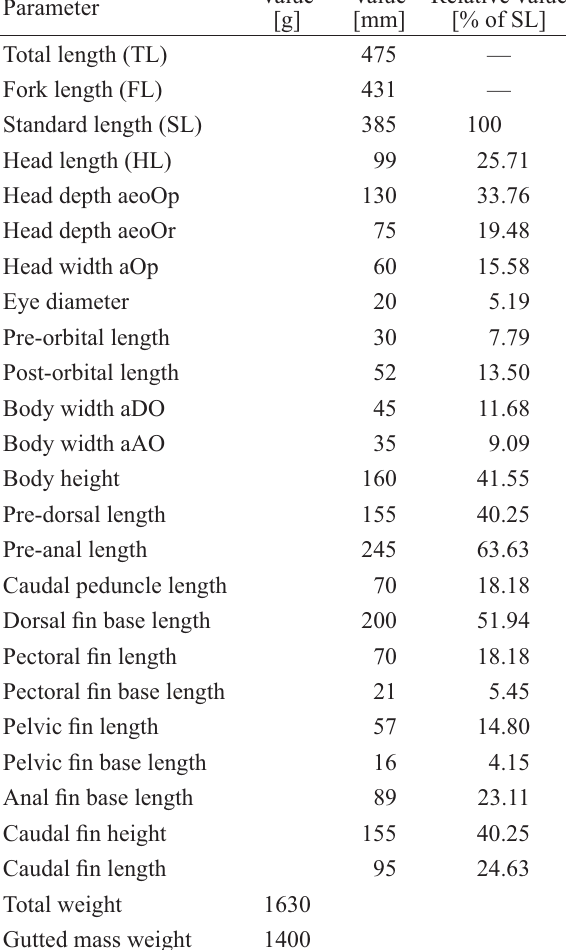
Morphological data for the specimen of Kyphosus saltatrix caught in Libyan waters